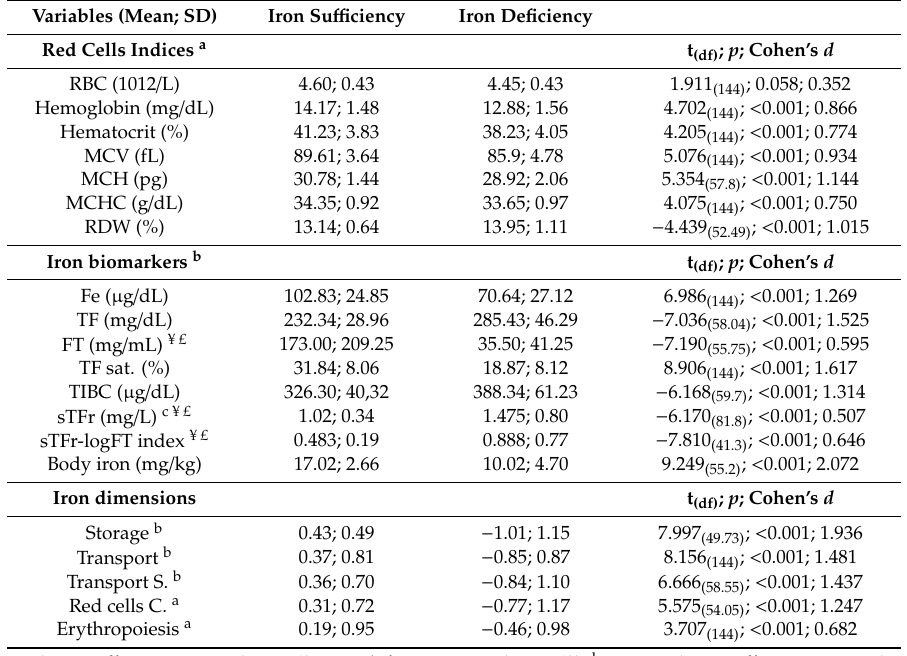
Table A4. Hematological characteristics of participants and di ff erences by group of iron status.